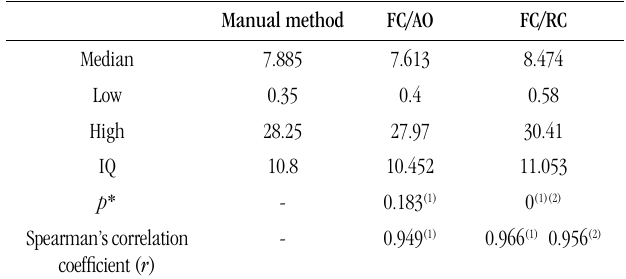
tABLE 2 – Comparison of results obtained by different reticulocyte count methods Manual